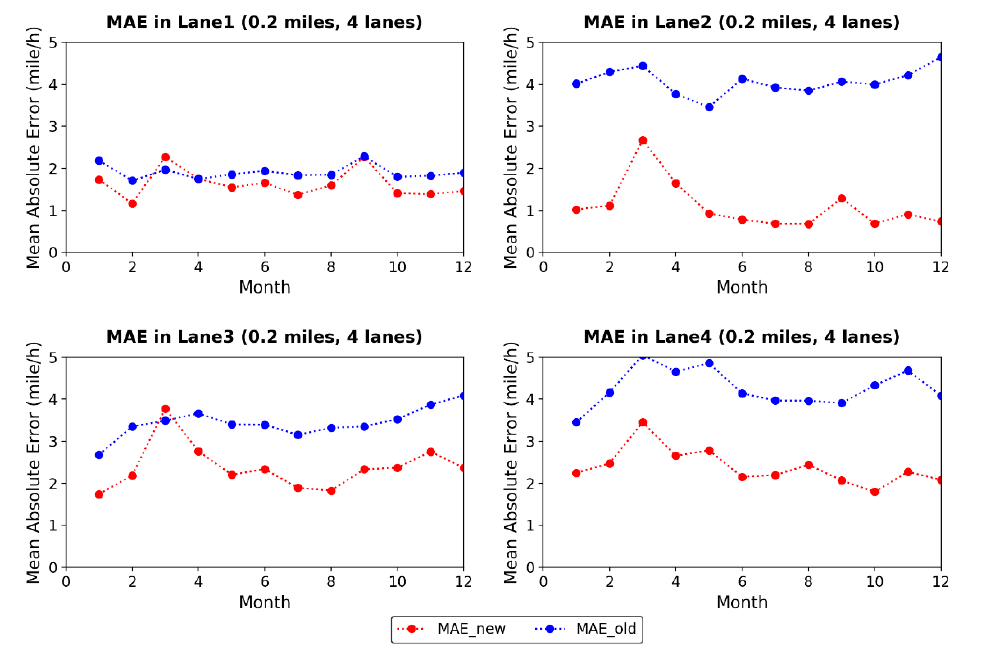
Figure 6. MAE curves of the new system and the old system in segment {0.2 miles, 4 lanes}.